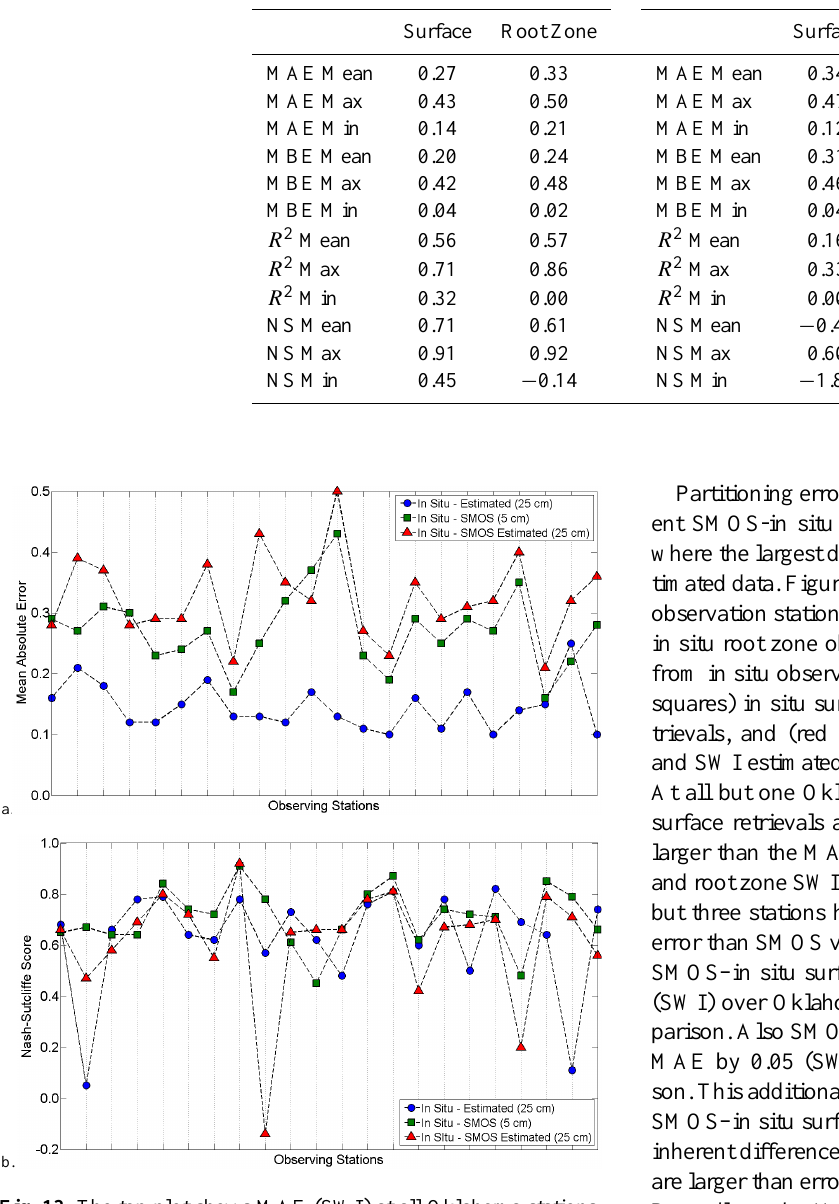
Figure 13 . The top plot shows MAE (SWI) at all Oklahoma stations. MAE is calculated between (blue circles) in situ surface observations and in situ root zone estimates, (green squares) in situ near-surface observations and SMOS surface retrievals and (red triangles) in situ root zone observations and SMOS root zone estimates. The bottom plot shows NS scores at all Oklahoma stations for the same dataset comparisons as in the top plot.